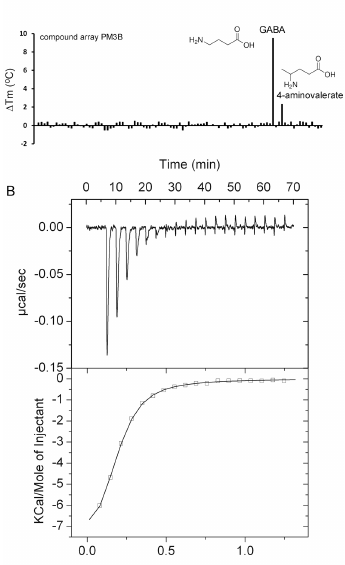
Figure 2. Identification of PA0222 as GABA binding protein. ( A ) Thermal shift assays of PA0222 and the compounds of array PM3B. Shown are T m changes with respect to the ligand-free protein. ( B ) Microcalorimetric titration of 10 µ M PA0222 with 200 µ M GABA (4.8 µ L aliquots). Upper panel: Raw titration data. Lower panel: Dilution heat corrected and concentration normalized integrated raw data. The line is the best fit using the “One Binding Site” model of the MicroCal version of